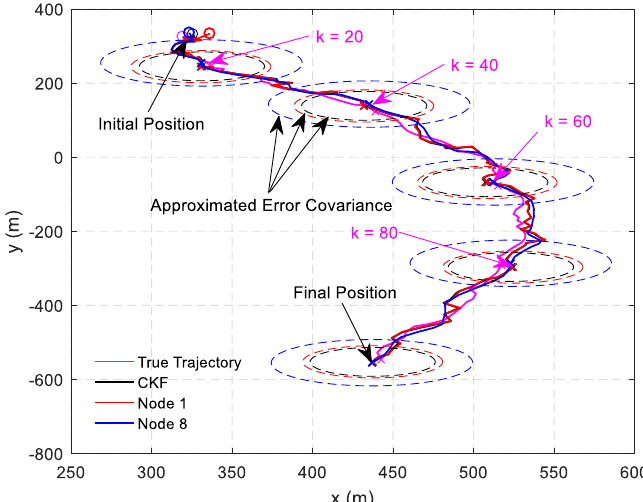
Figure 2. State estimation results: distributed hybrid information weighted consensus filter (DHIWCF) versus centralized Kalman consensus filter (CKF).